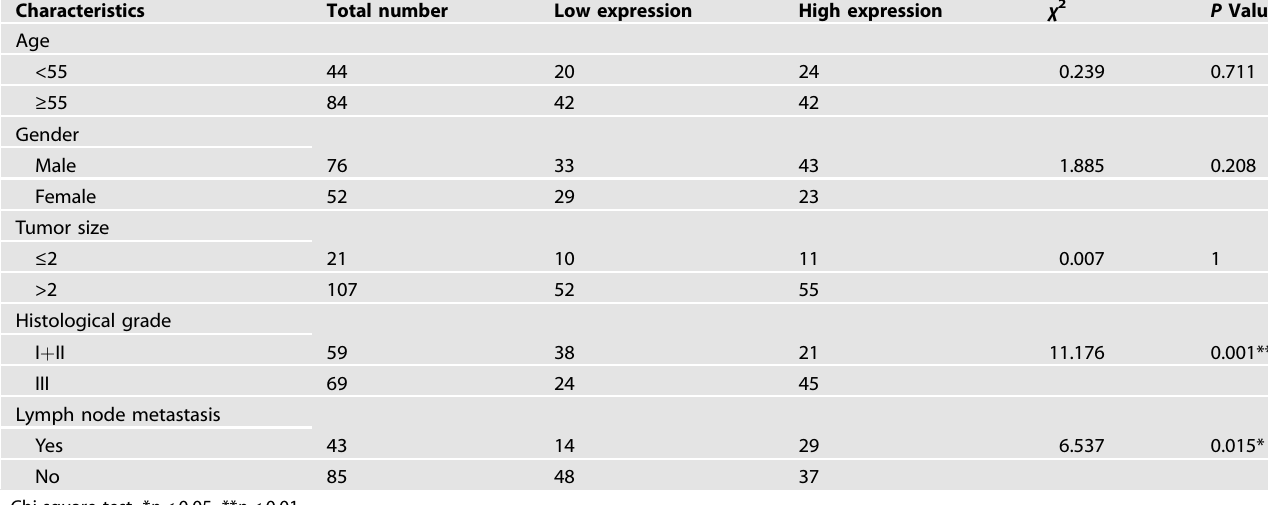
Table 1. Correlation between hsa_circ_0007367 expression and clinicopathological characteristics of PDAC patients ( N = 128). Characteristics